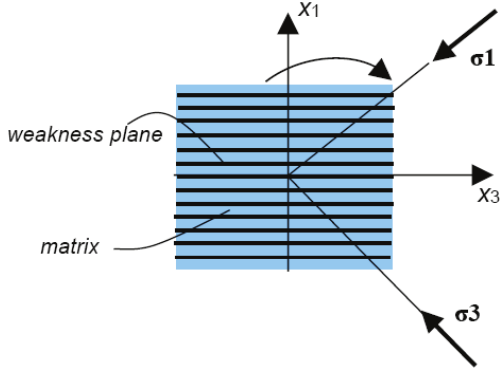
Fig. 1. Model: Pariseau matrix with the singular plane of